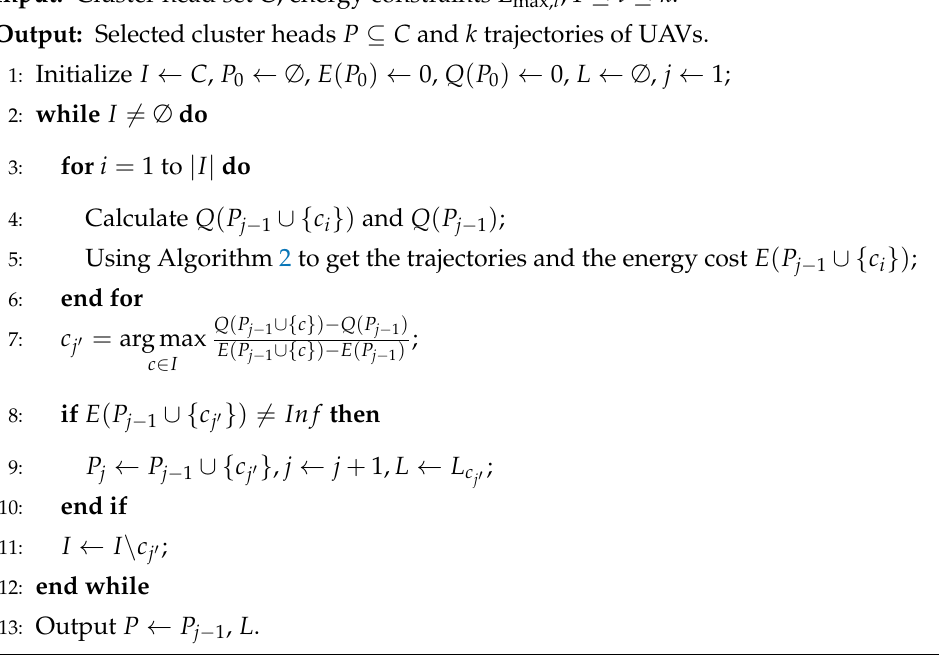
Using Algorithm 2 to get the trajectories and the energy cost E ( P j − 1 ∪ { c i } ) ;